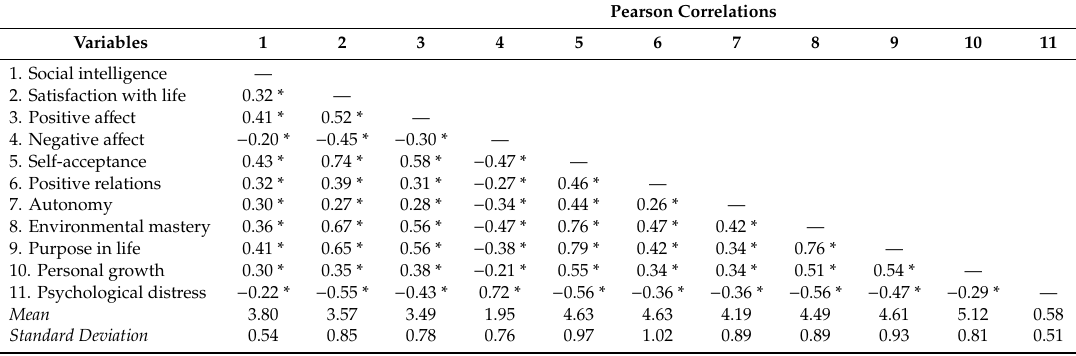
Table 2. Descriptive statistics and Pearson correlations between social intelligence, components of subjective well-being, dimensions of psychological well-being, and psychological distress.